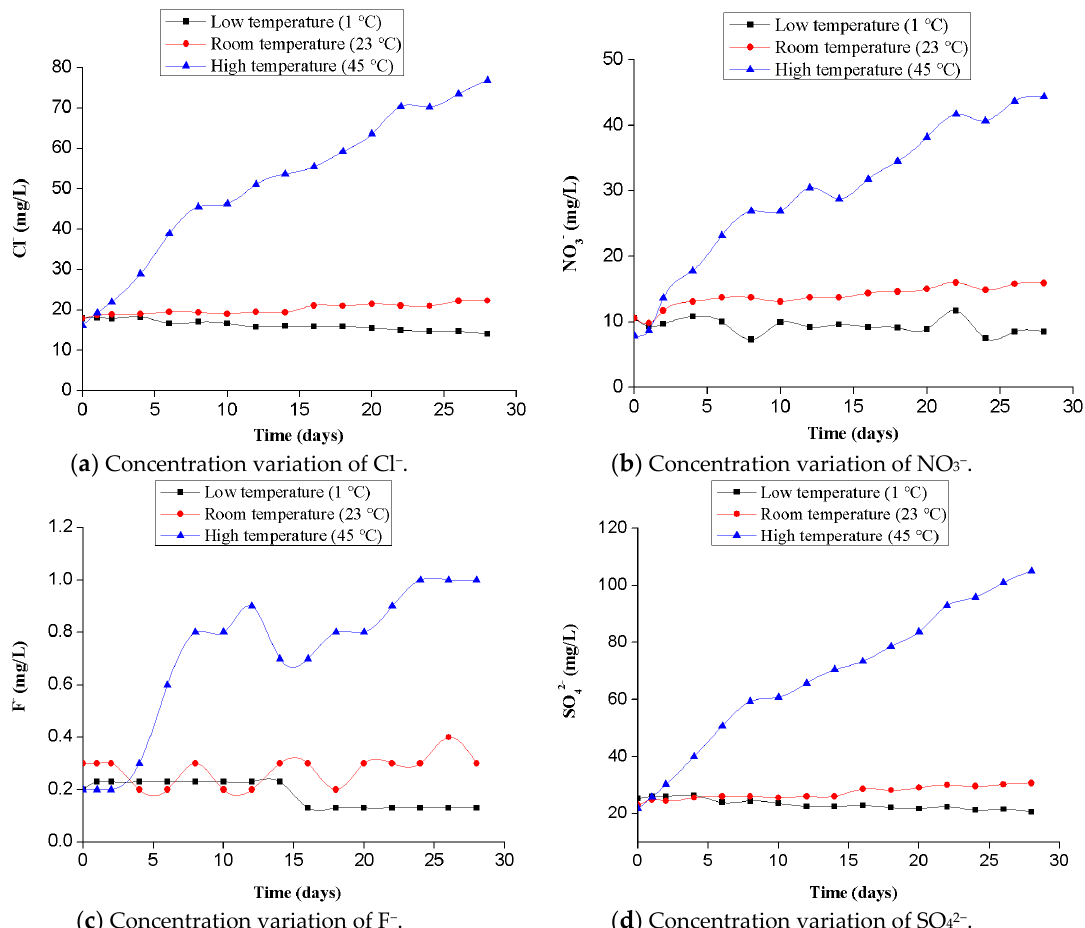
Figure 7. Curves of the concentration variation in the main anions in the circulating aqueous solution at different temperatures.